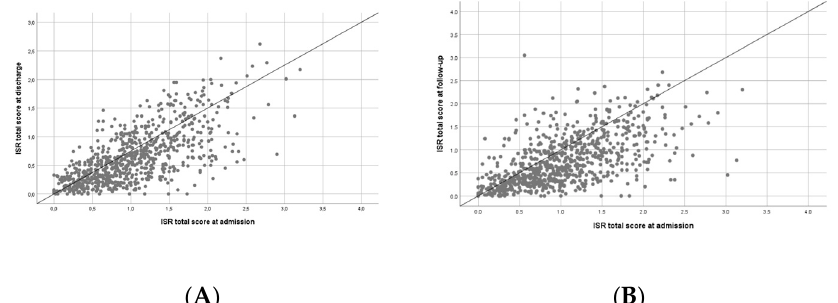
Figure 4. E ff ect of multimodal intervention. The scatter blots illustrate the e ff ect of the multimodal intervention at ( A ) discharge from the TCM Hospital or ( B ) follow-up. Each dot represents one patient. The dots below the line represent patients who benefitted from intervention, the dots on the line represent patients with no e ff ect, and the dots above the line represent patients with aggravation of symptoms at ( A ) discharge or ( B ) follow-up with respect to admission.